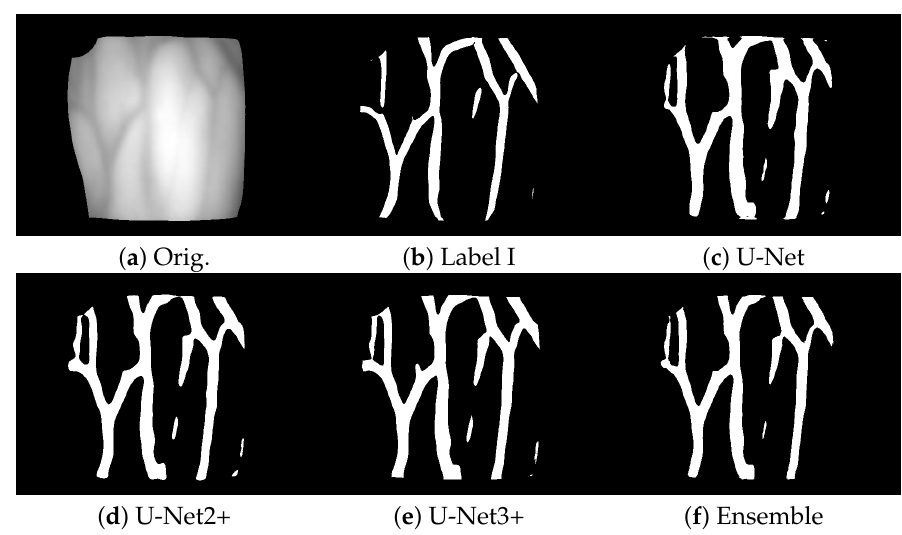
Figure 19. Visual comparison of U-Net, U-Net++ and U-Net3+ with Dice loss.